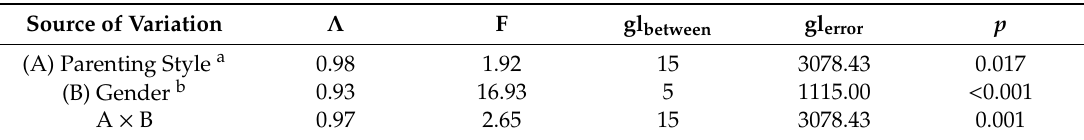
Table 4. MANOVA factorial (4 a × 2 b ) for adolescent dating violence (online and o ffl ine) for mothers ( N = 1132).